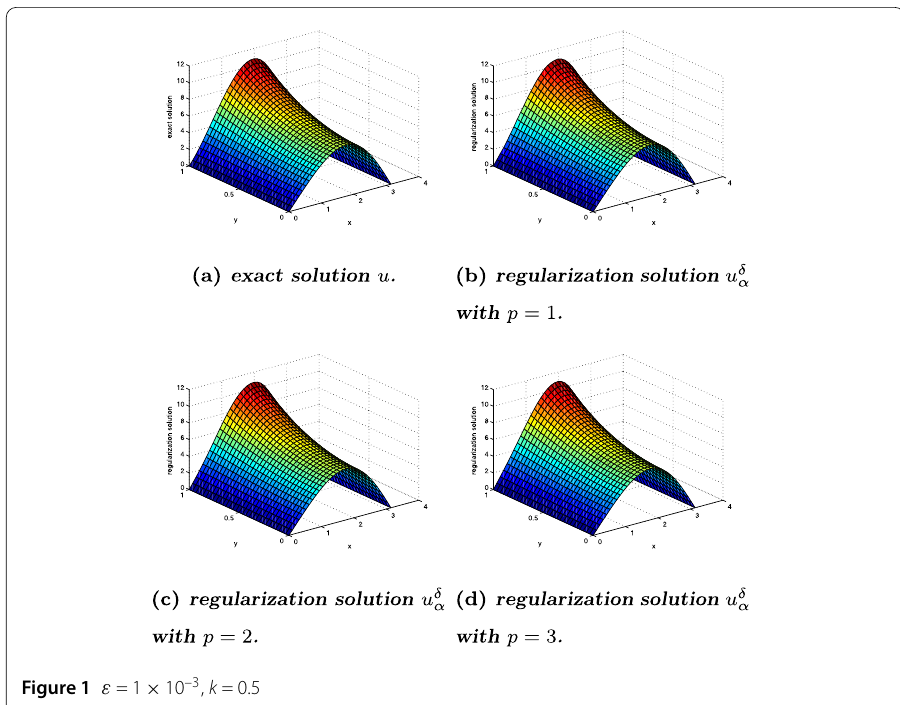
Figure 1 ε = 1 × 10 –3 , k =